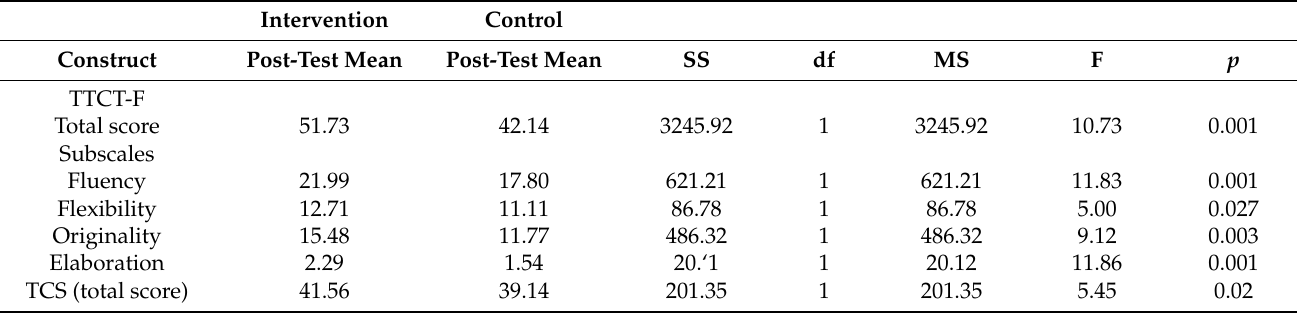
Table 4. ANCOVA of adjusted Post-test scores on the TTCT-F and TCS for the Intervention ( n = 61) and Control ( n = 84)